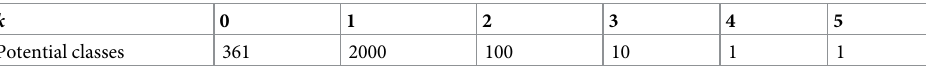
k 0 1 2 3 4 5 Potential classes 361